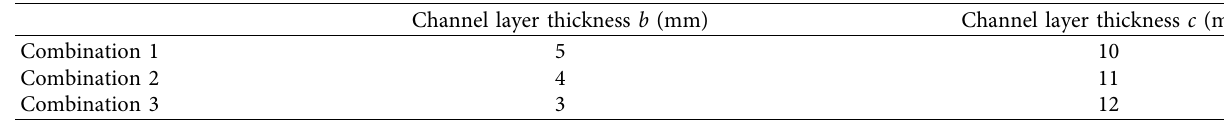
Figure 11: Curves of sound absorption characteristics of acoustic metamaterials with different channel thicknesses. Table 1: Combinations of channel layer thicknesses.